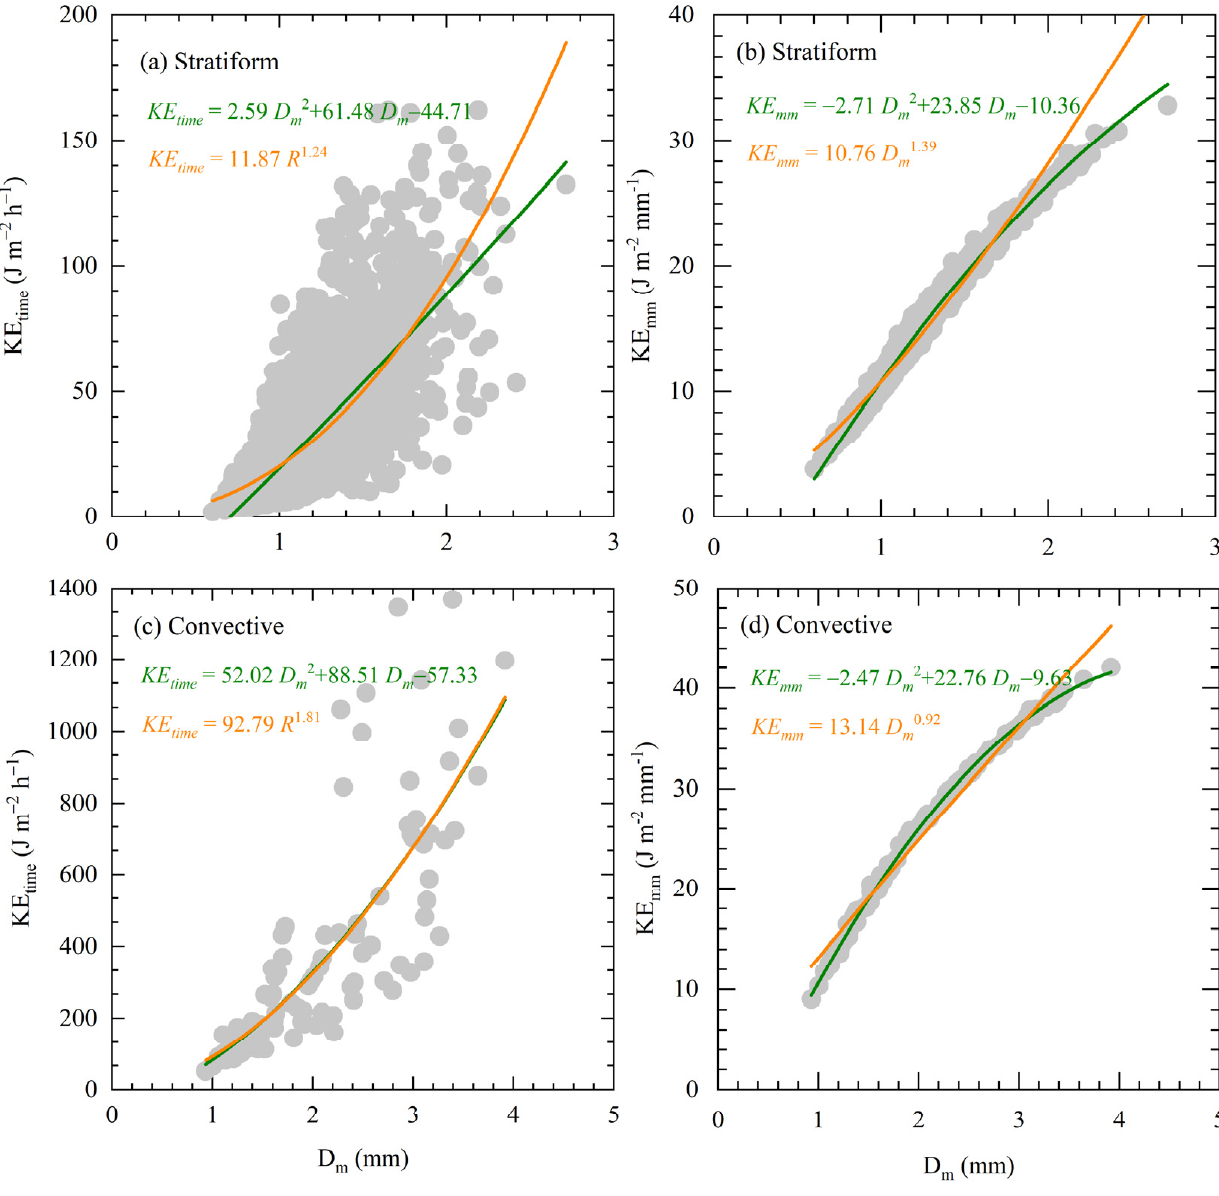
Figure 14. Scatterplots of KE time ( KE mm ) versus D m , and the KE time – D m and KE mm – D m relations for ( a , b ) stratiform and ( c , d ) convective rainfall in Zhaosu.